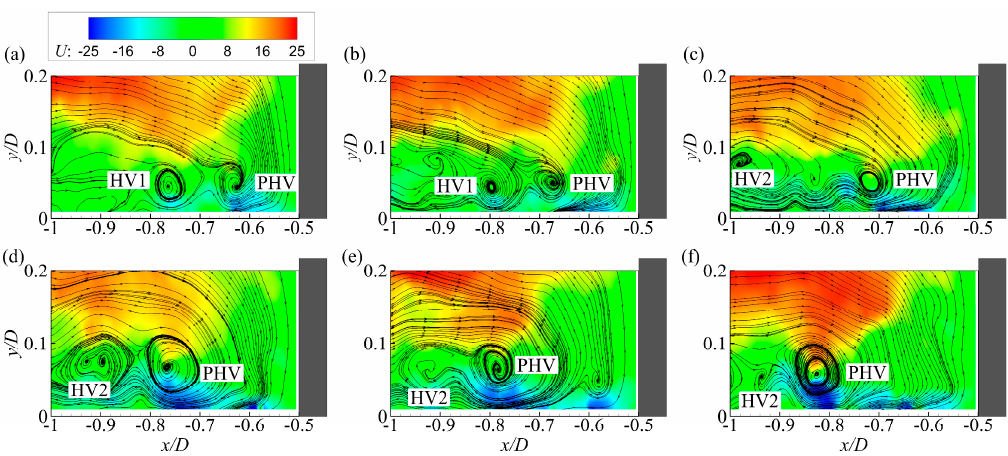
Figure 10. Sequence of instantaneous velocity fields illustrating the large-amplitude upstream motion of a PHV for case C13900. ( a ) t = 0; ( b ) t = 0.35 D / U m ; ( c ) t = 0.70 D / U m ; ( d ) t = 1.04 D / U m ; ( e ) t = 1.75 D / U m ; ( f ) t = 2.08 D / U m . ( f ) t = 2.08 D / U m